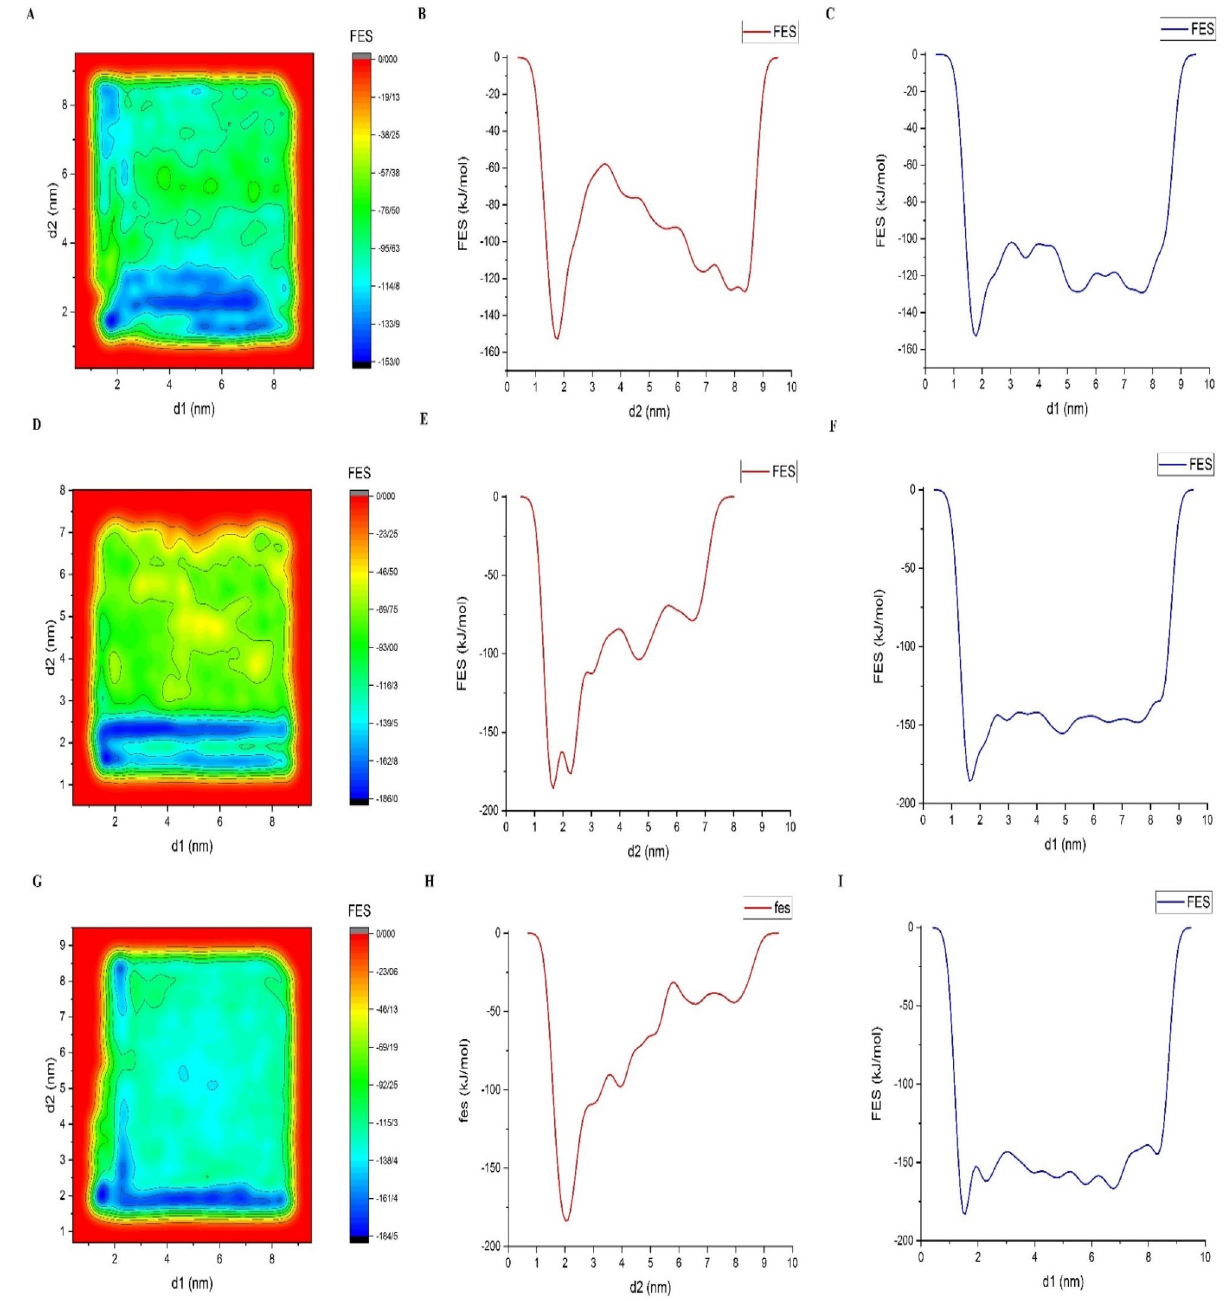
Figure 5. Left: Free energy landscape as a function of d1 and d2, which are the distance of the center of mass of DOX from the center of mass of Hexakis nanotube and DMA polymer chain, Middle: Free energy surface for Hexakis and different orientations of DOX, Right: Free energy surface for Hexakis and different orientations of DMA polymer chain,